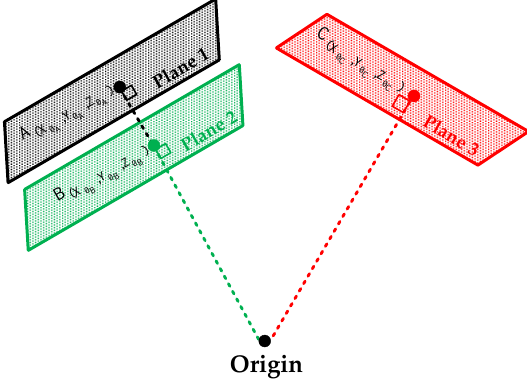
Figure 4. Defined attribute points for three locally-classified planar neighborhoods.